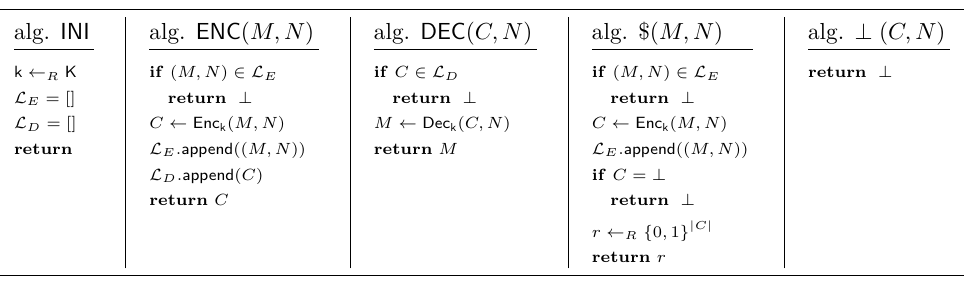
Figure 5: Algorithms for defining nAE